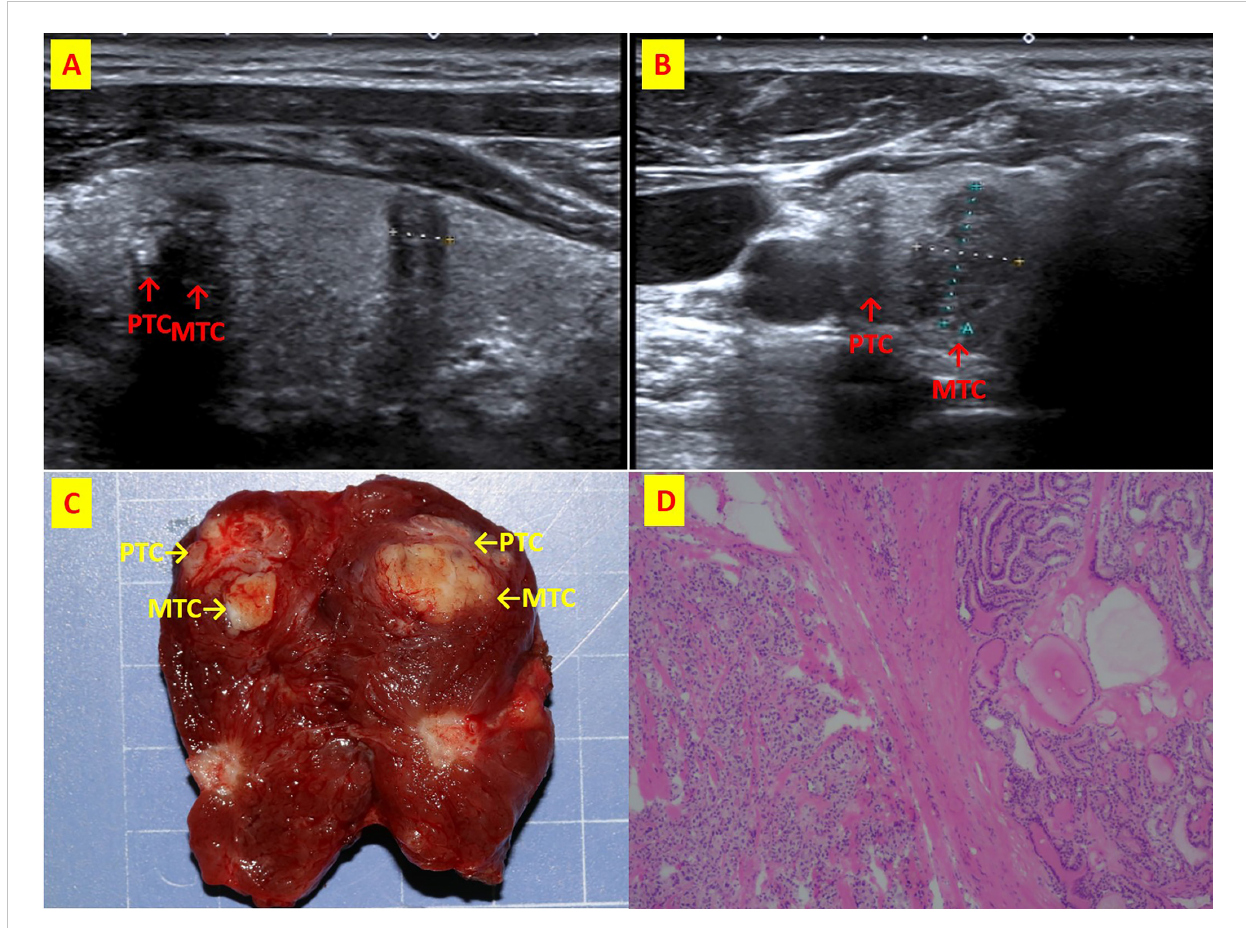
FIGURE 4 The patient n.6 that MTC and PTC are located in the right thyroid lobe closely. (A) ultrasound of longitudinal; (B) Ultrasound of transverse; (C) Intraoperative resection of tumor pro fi le; (D) Histological sections of HE